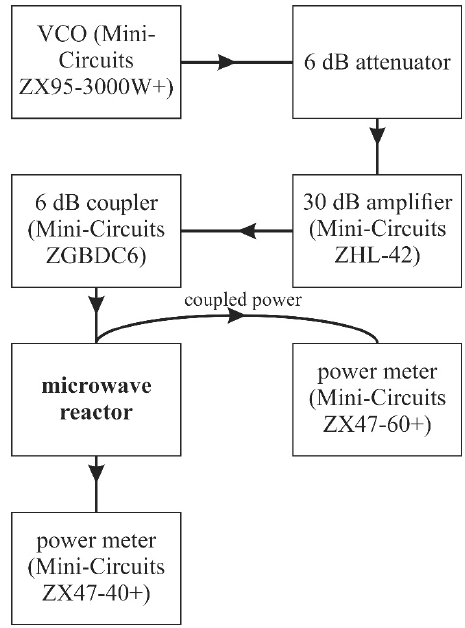
Figure 10. Scheme of setup for sample treatment in microfluidic reactor.